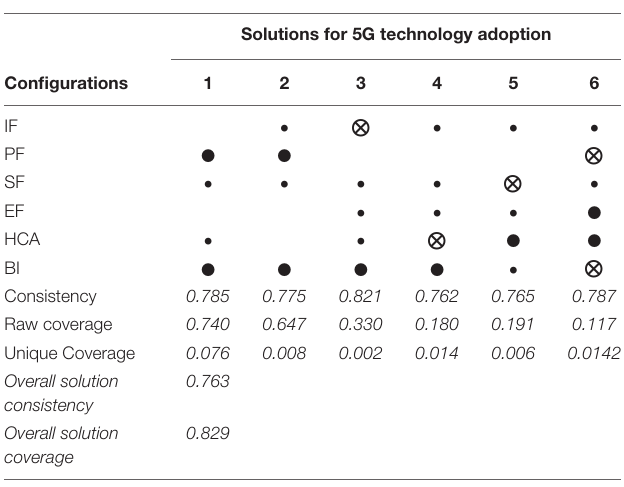
TABLE 9 | fs QCA findings. TABLE 10 | Solutions (models) from the